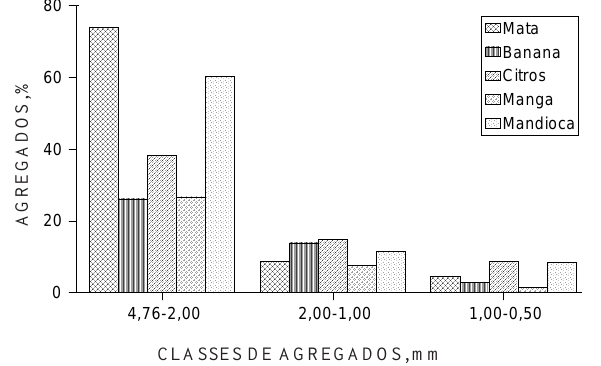
Figura 1. Distribuição de agregados (% peso) em classes de tamanho (mm) no horizonte superficial de um Latossolo Amarelo álico sob diferentes coberturas